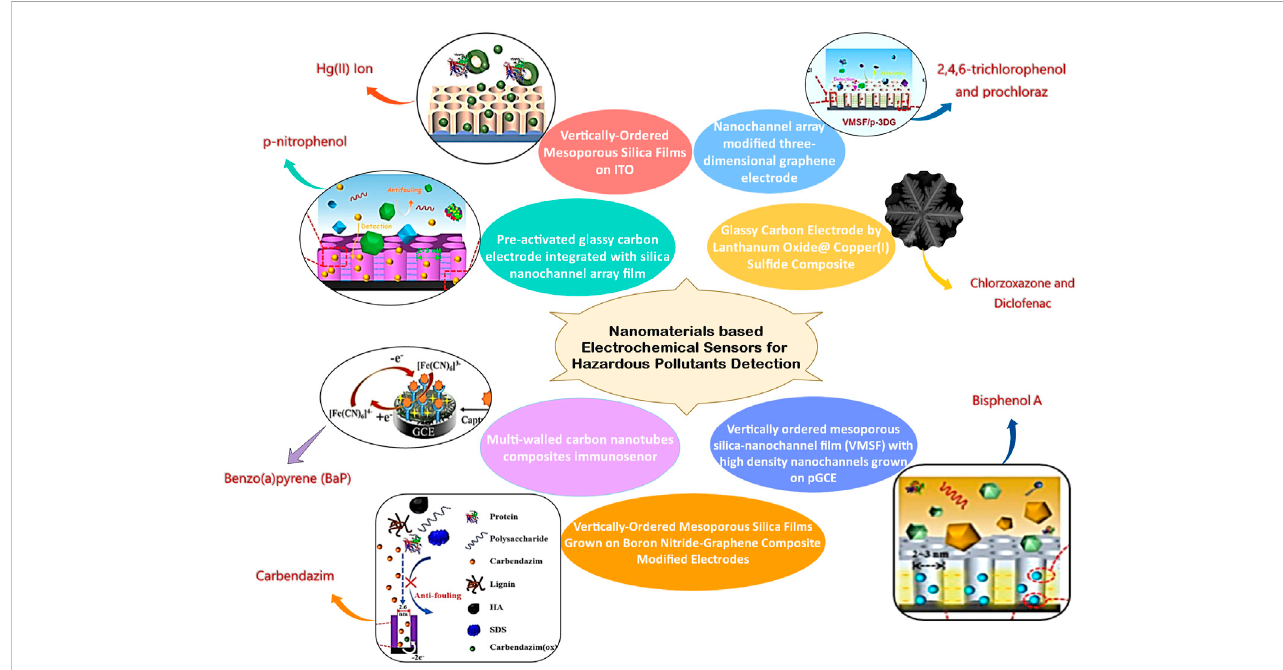
FIGURE 1 Cumulative representation of various sensors reported by the authors of this Research